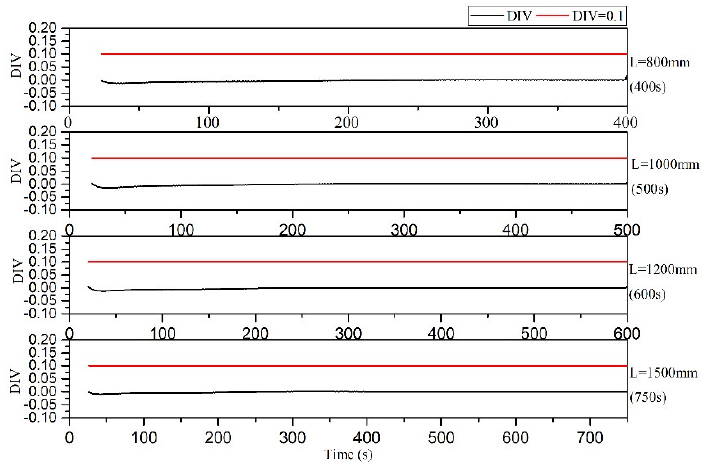
Figure 26. DIV diagram of temperature monitoring in microreactor under different residence times.